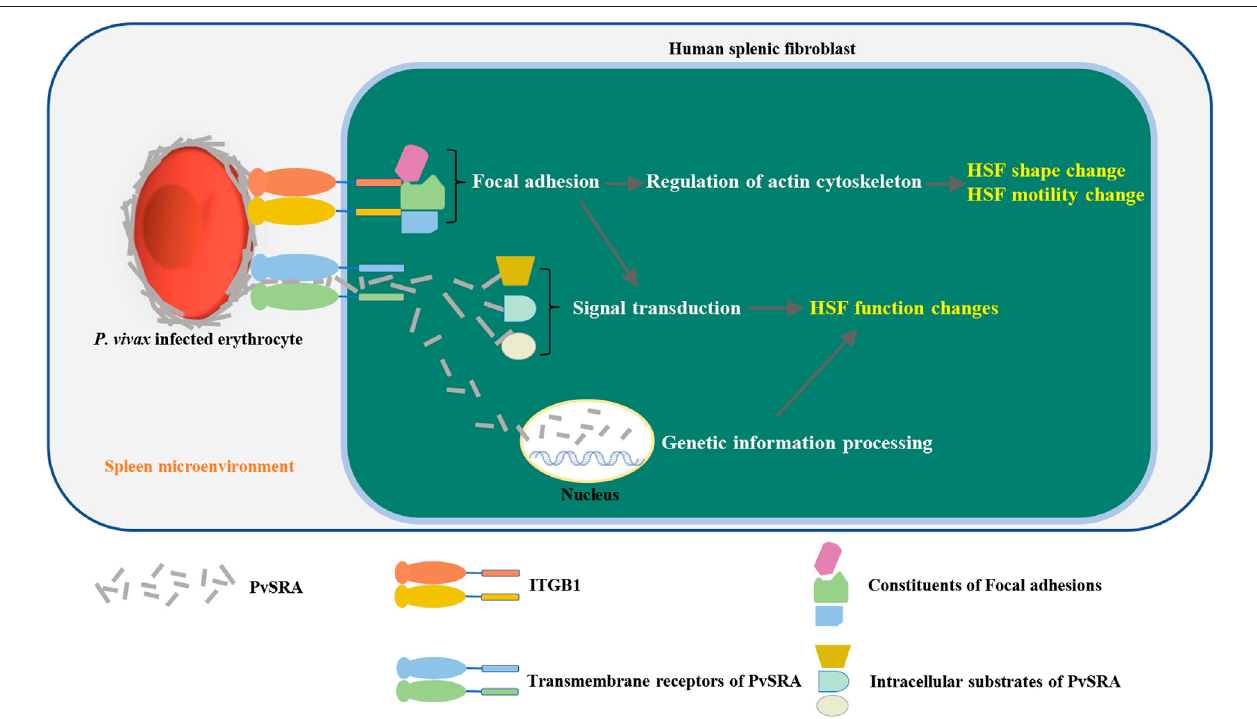
FIGURE8| Schematic diagram oftheimmuneevasionhypothesisof P.vivax inthespleen.After enteringthe spleen, P.vivax – infected erythrocytesadheretoHSF throughligand(PvSRA) – receptor(ITGB1)axis.ThisisfollowedbytheformationofthefocaladhesionstructureonHSFsurface,leadingtotheactincytoskeletonremodel, and then, the original shape and motility of HSF was affected and changed to induce the formation of barrier cells. Besides, focal adhesion might also modulate the capabilities of HSF by further activating FAK pathway and downstream pathway (i.e., MAPK pathway). In addition, PvSRA might translocated into intracellular environment throughother substrates to further affect or interfere thesignal transductionor genetic information processing ofHSF throughother PPIs. This fi nally would alter the immunoregulation role of HSF in the spleen to result in the immune evasion of P. vivax .